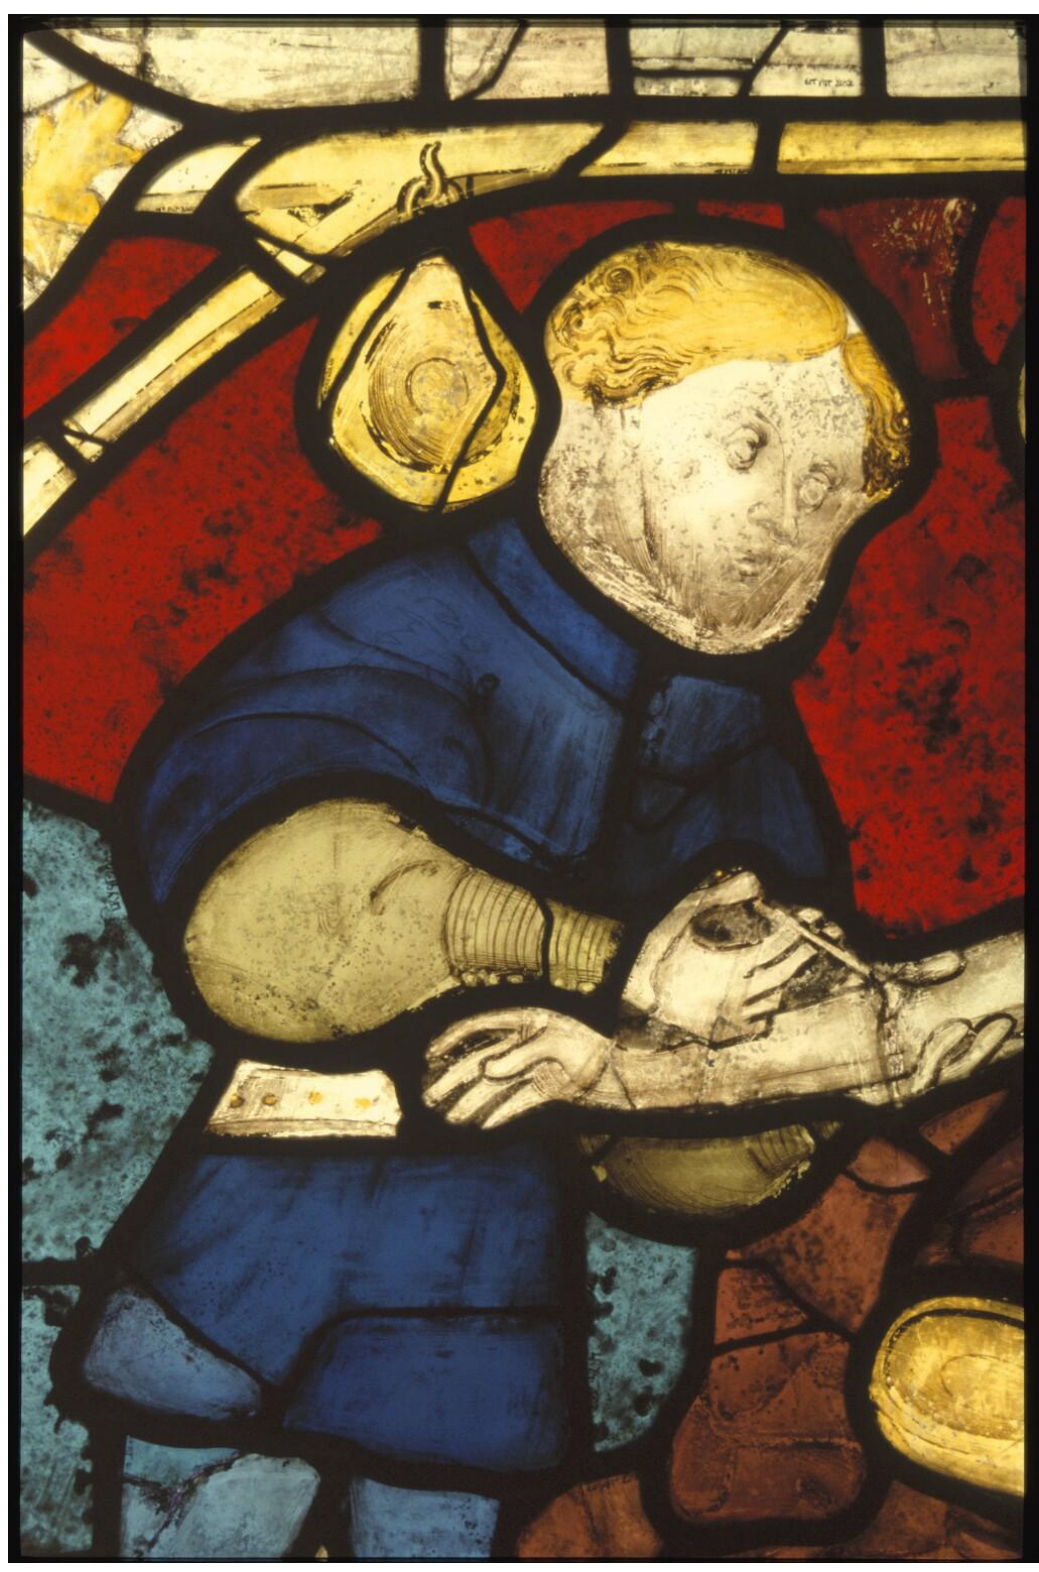
Figure 9. A surgeon uses a lancet. From the St William Window of c. 1425, York Minster CVMA nVII panel 18a .